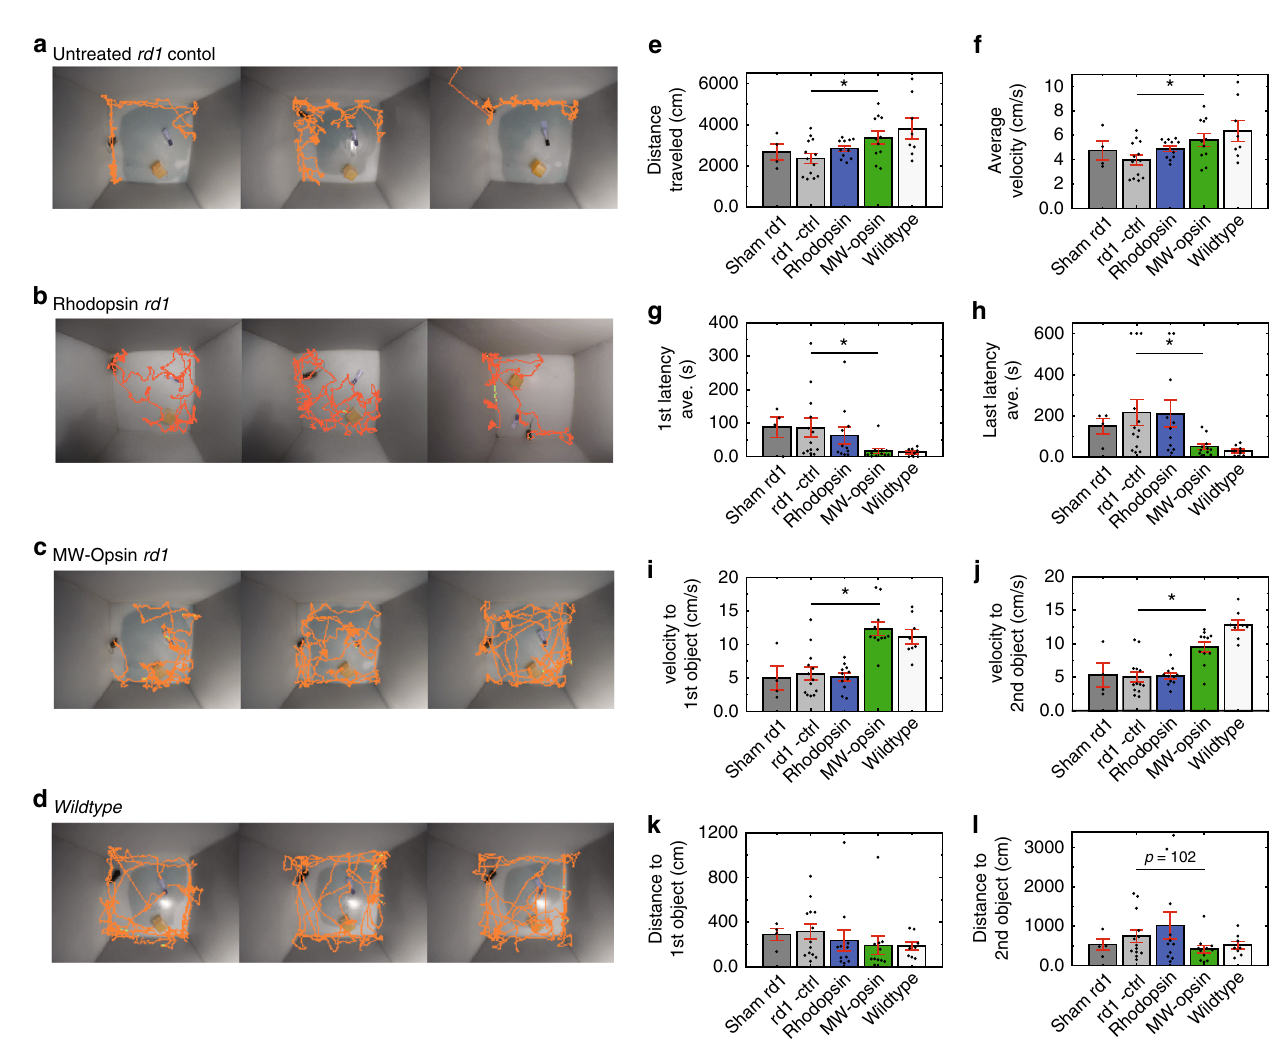
Fig. 5 Restoration of visually guided exploratory behavior by MW-opsin. a – d Open fi eld behavioral arena containing two novel objects with traces of the fi rst minute locomotion track from 3 representative animals per condition: untreated r d1 mice ( a ), rhodopsin expressing r d1 mice ( b ), MW-opsin expressing rd1 mice ( c ), and wt mice ( d ). e , f Total distance traveled and average velocity of mice during 10 min of exploration in the novel object behavior box. g – l Latency to exploration of fi rst object ( g ), cumulative latency to exploration of the second object ( h ), velocity of travel to the fi rst ( i ) and second object ( j ), distance traveled to fi rst ( k ) and second object ( l ) for rd1 -sham injected (dark gray) ( n = 4), rd1 untreated (gray) ( n = 13), rhodopsin (blue) ( n = 11), MW- opsin (green) ( n = 11) and wt (white) ( n = 8). Values are mean + SEM. Statistical signi fi cance assessed using a two-tailed t test (* p <